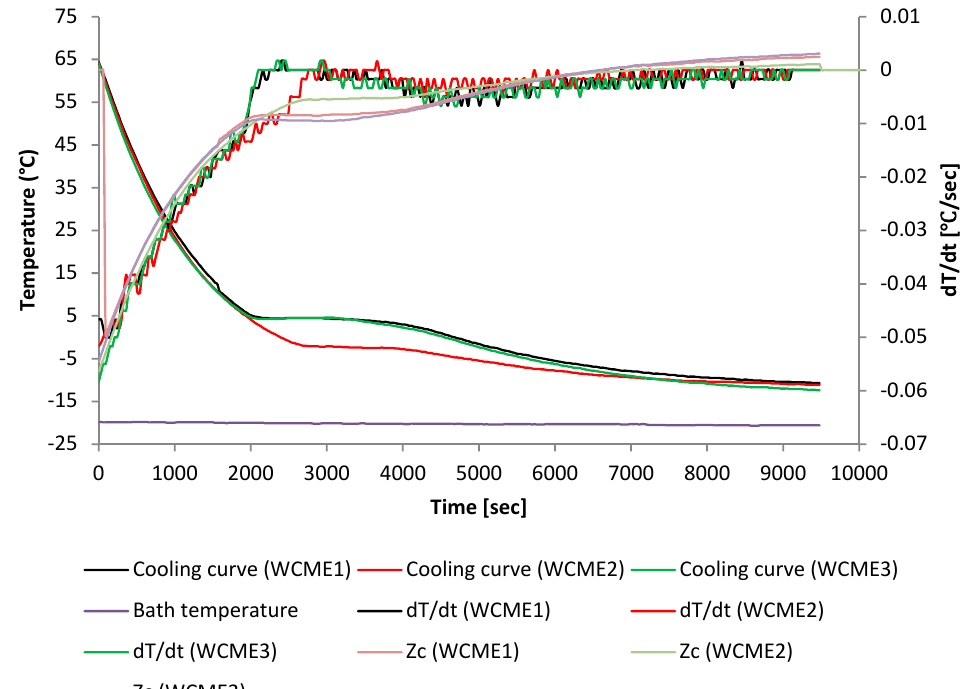
Figure 8. Cooling curve analysis and rate of change of temperatures with respect to time for all pure biodiesel